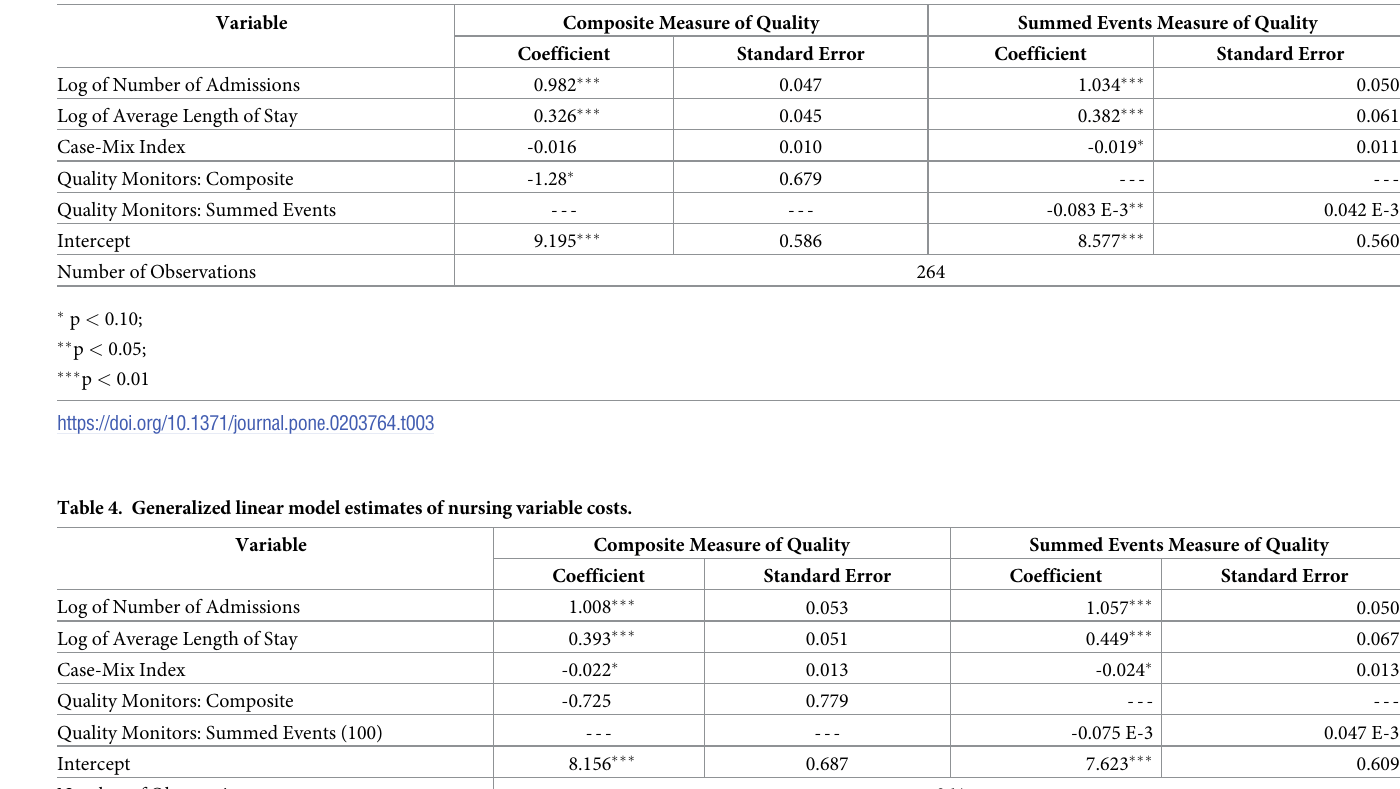
Table 3. Generalized linear model estimates of total variable direct costs.